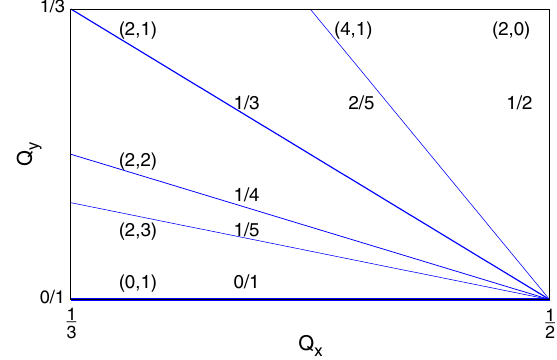
FIG. 3 (color online). Graphical representation of the resonance sequence of order 5 attached to 1 = 2 . The resonance lines are represented by ð a; b Þ and the corresponding Farey fraction by p=q . Note that ð a; b Þ ¼ ð 2 p; q − 2 p Þ . The free term c to complete the resonance equation is c ¼ a= 2